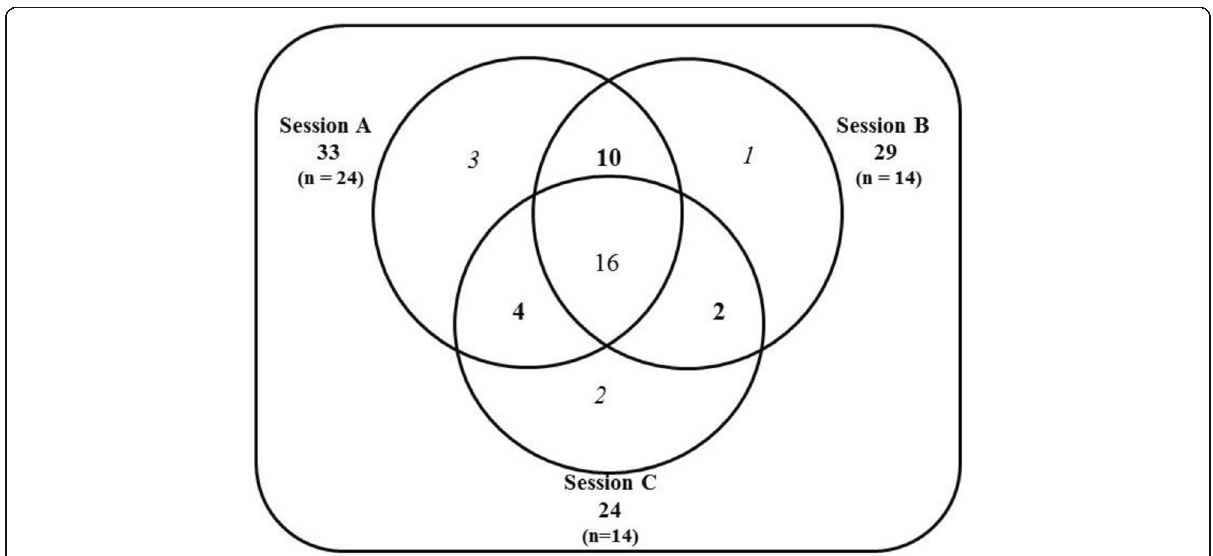
Fig. 1 Venn Diagram of PIO Generation from the 3 Brainstorming Sessions. Legend: Bolded numbers in the outer circles indicate total PIOs identified in that session. The intersection of all 3 sessions shows 16 PIOs were common across the sessions. Italicized numbers in the outer circles show unique PIOs identified in that session, and bolded numbers in the inner circles show PIOs present in that 2-session